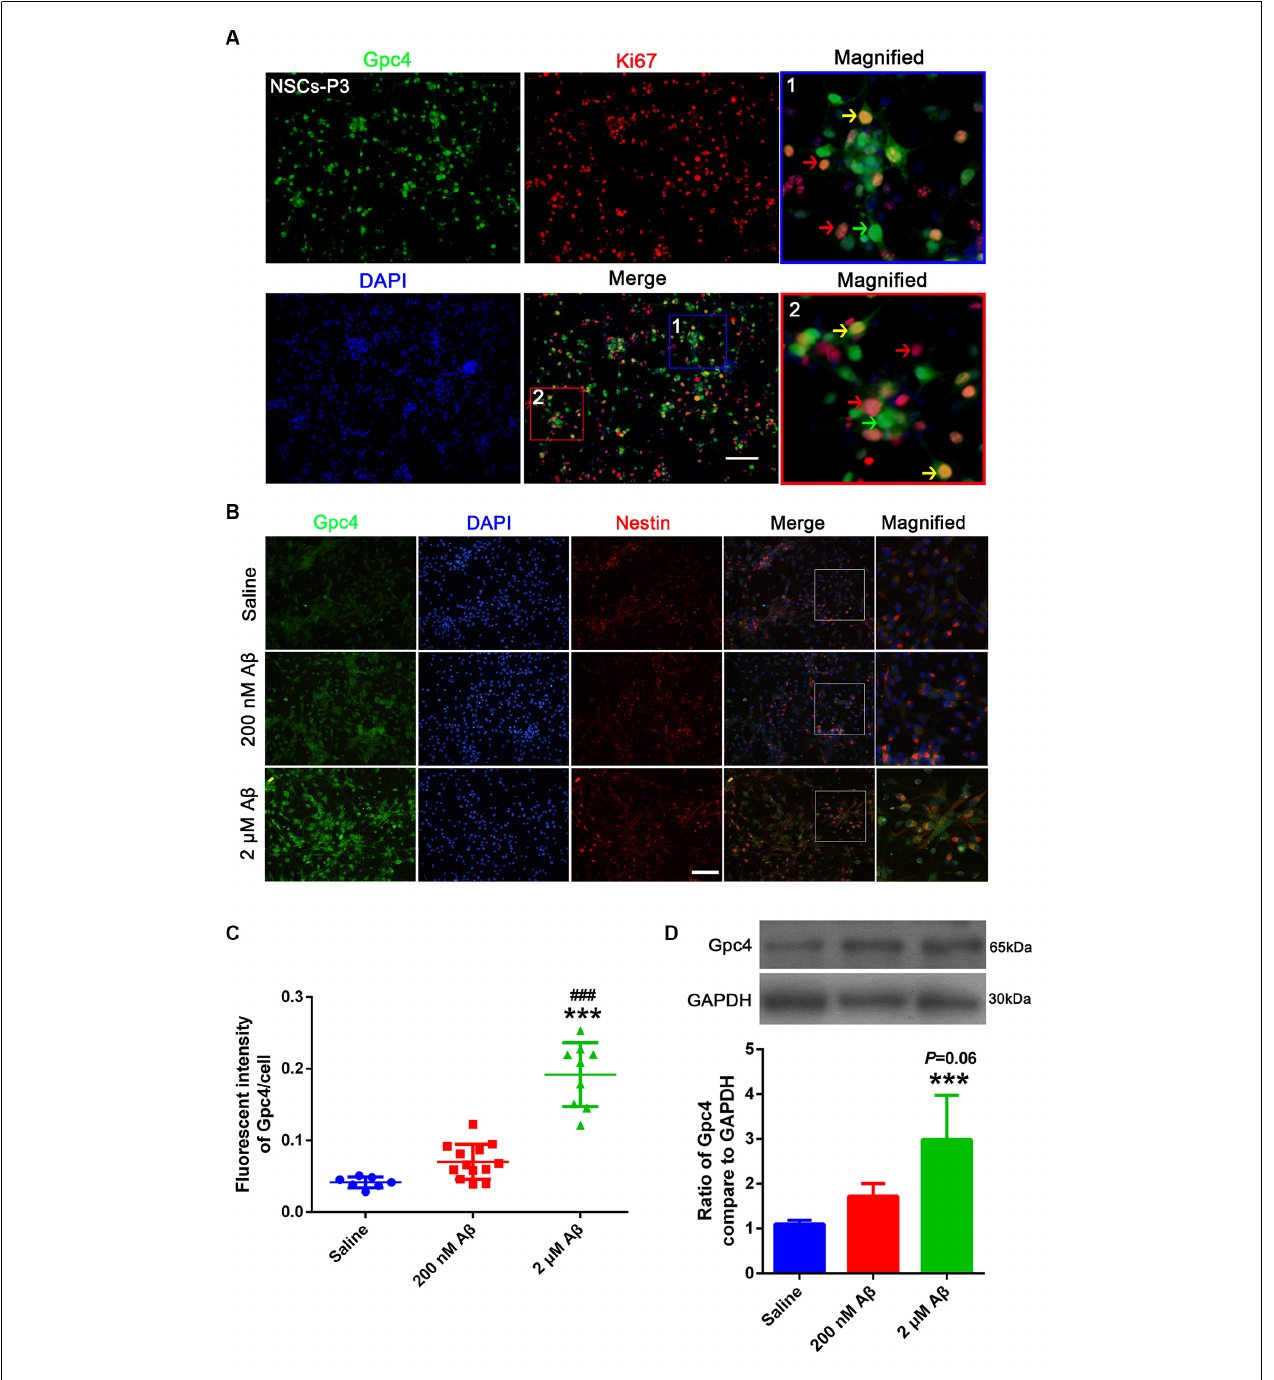
FIGURE 3 | A β upregulated Gpc4 expression in NSCs. (A) Immunofluorescence analysis revealing the protein expression of Gpc4 (green) with Ki67 (red) in NSCs. Nuclei were counterstained with DAPI (blue). Gpc4 was widely expressed in NSCs (green). Double positive Gpc4/Ki67 NSCs (yellow arrow), Gpc4-negative Ki67-positive NSCs (red arrow), and Gpc4-positive Ki67-negative NSCs (green arrow) were also observed. Scale bar = 50 µ m. (B,C) NSCs were treated with 0, 200 nM, and 2 µ M A β for 24 h. Immunofluorescence analysis revealed the expression of Gpc4 (green), nestin (red), and DAPI (blue). Gpc4 colocalized with nestin-positive NSCs. *** represents 2 µ M A β vs. saline, P < 0.0001, ### represents 2 µ M A β vs. 200 nM A β , P < 0.0001. Scale bar = 50 µ m. (D) NSCs were treated with 0, 200 nM, and 2 µ M A β for 24 h before western blotting. Western blotting was used to detect Gpc4 (56 kDa) and GAPDH (35 kDa) expression levels. *** represents 2 µ M A β vs. saline, P = 0.007. Gpc4, glypican 4; NSCs, neural stem cells; DAPI, 4 (cid:48) ,6-diamidino-2-phenylindole; GAPDH, glyceraldehyde 3-phosphate dehydrogenase.